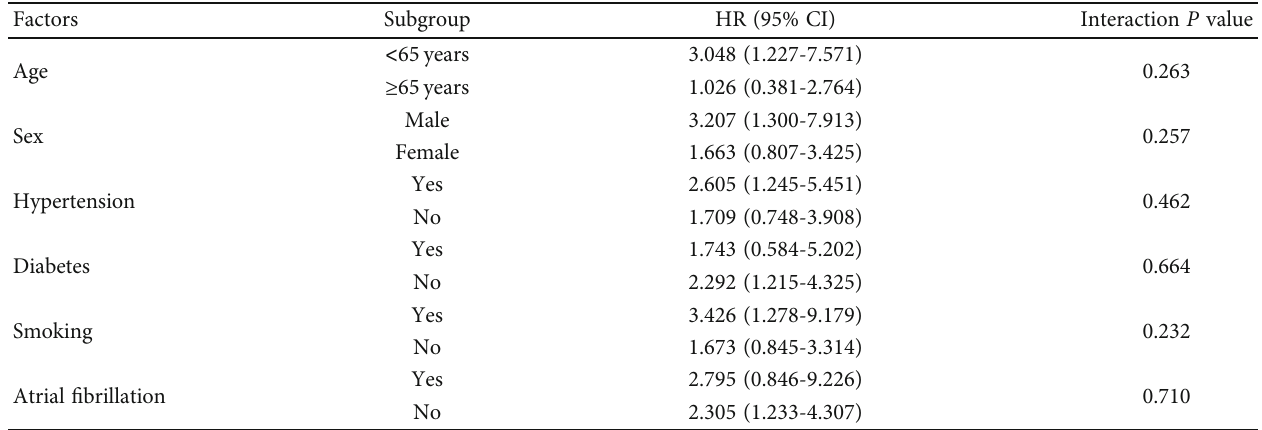
Table 4: Subgroup analysis of the association between high WMR and